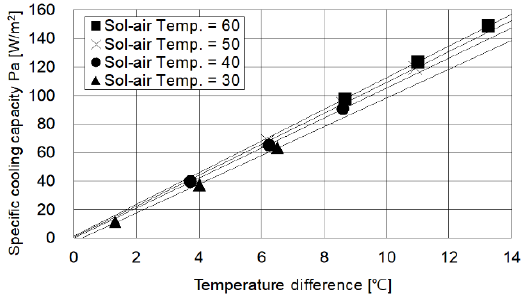
Figure 17. Cooling capacity according to sol-air temperature.